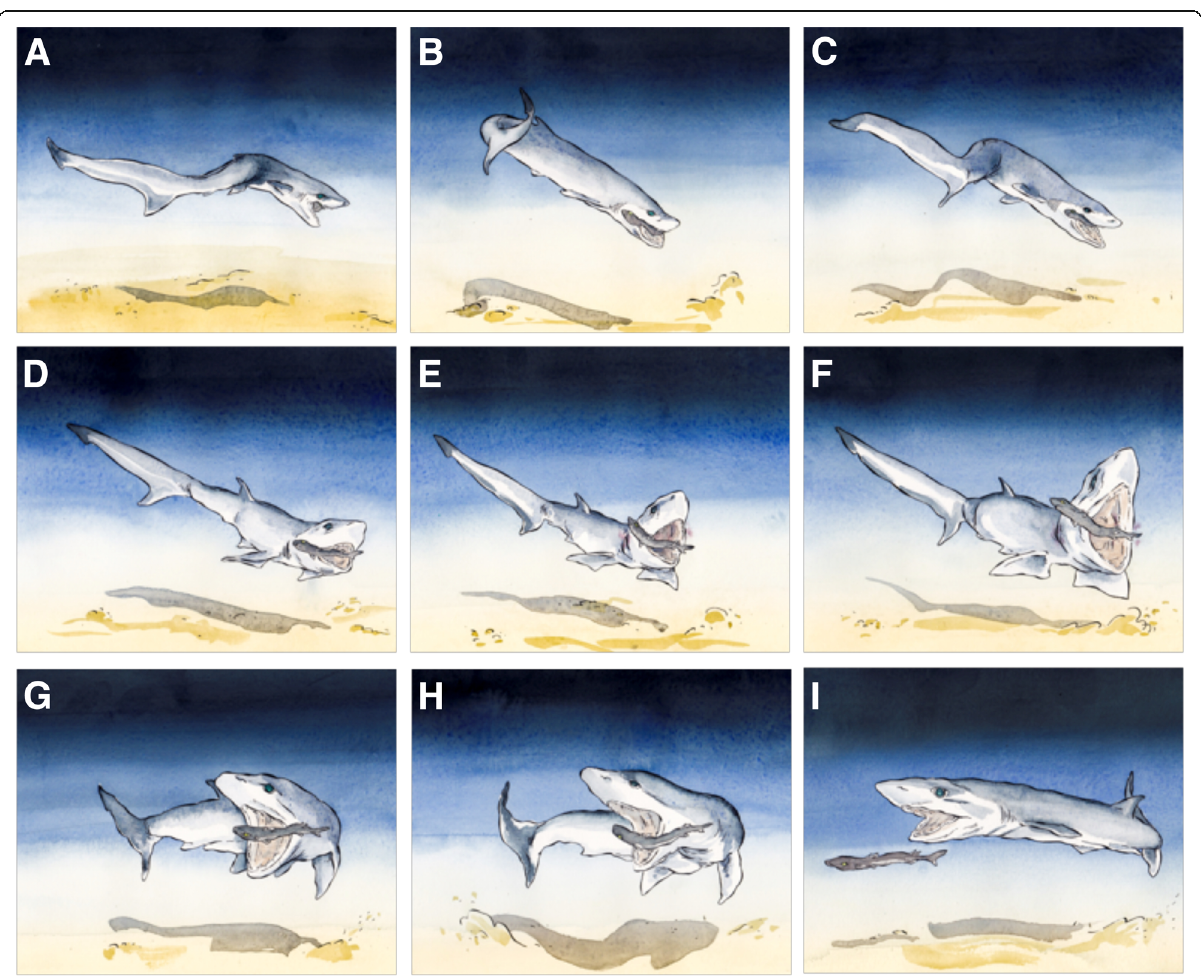
Fig. 6 Schematic time-lapse of hunting behavior of H. perlo on an E. splendidus where the spine defensive function is illustrated (images taken from video footage see supplemental